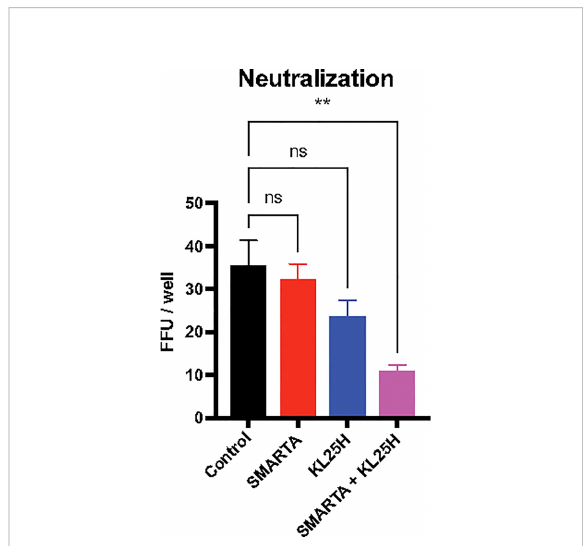
FIGURE 7 Combined therapy with CD4 T cells and B cells